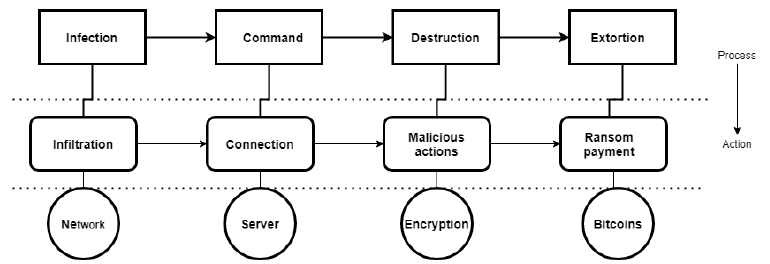
Figure 4. Ransomware processes and infiltration